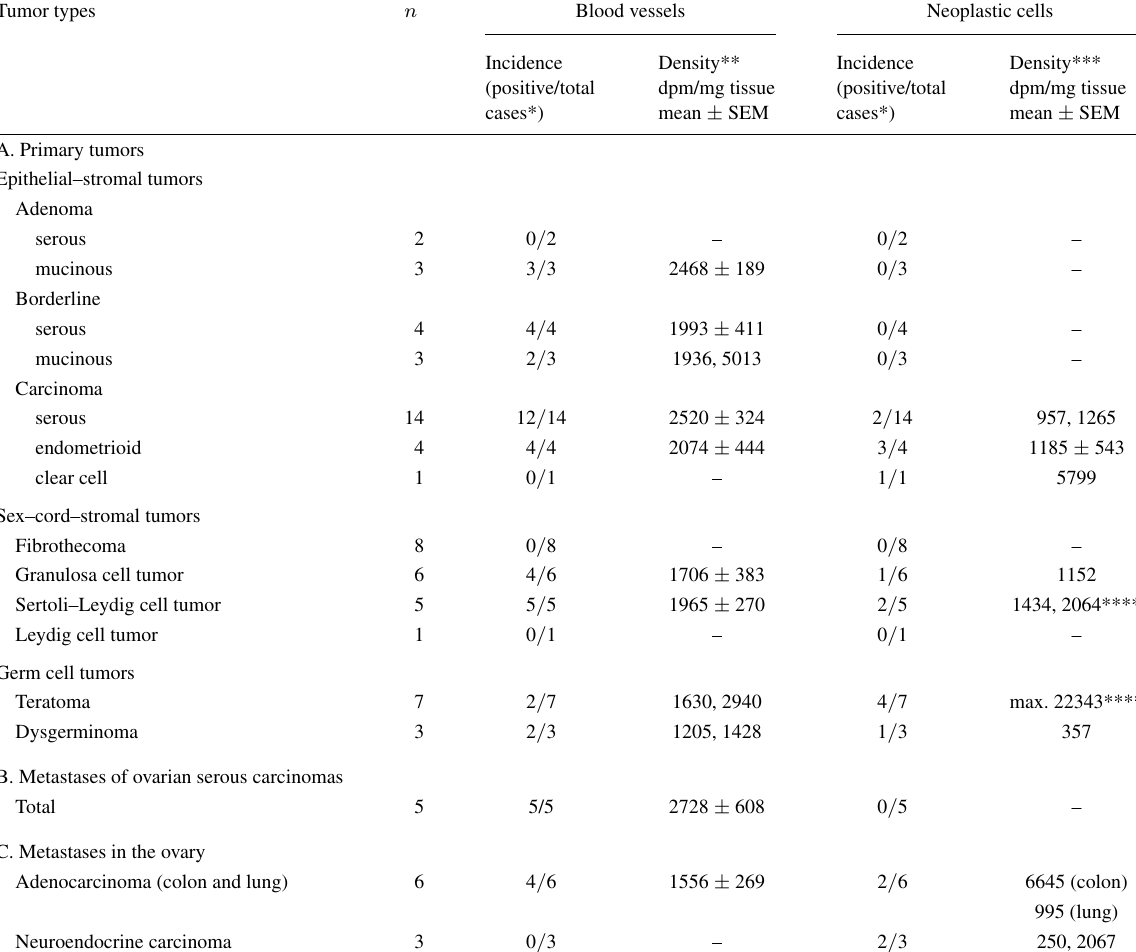
Location, incidence and density of GRP-receptors per tumor class in vascular and/or neoplastic compartments of ovarian